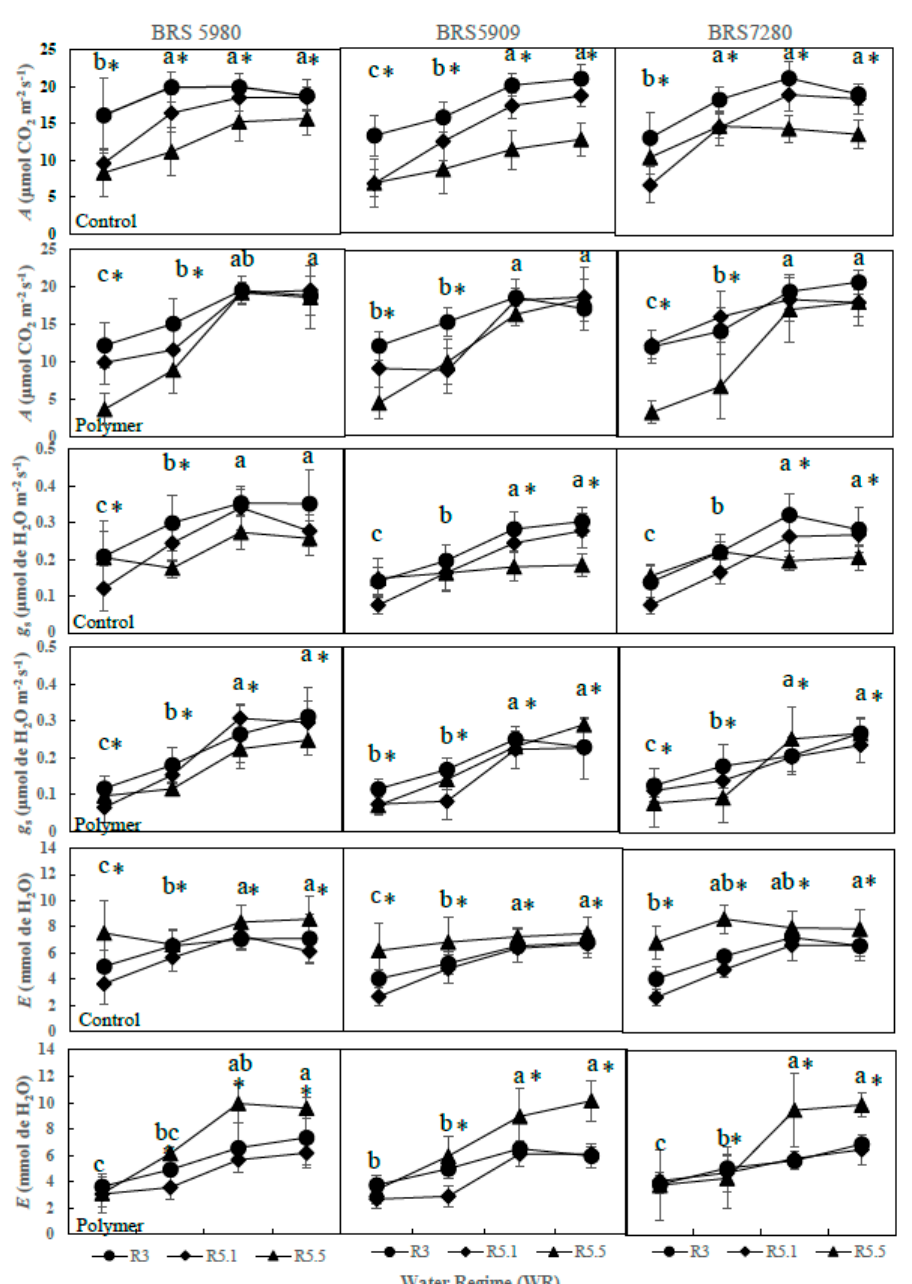
Figure 7. Photosynthesis, ( A ), stomatal conductance ( g s ) and transpiration ( E ) in three soybean cultivars submitted to four water regimes (WR) in three phenological stages of soybean development with and without polymer supply (WR1 167 mm, WR2 237 mm, WR3 341 mm, WR4 534 mm), in 2017. Lowercase letters indicate differences between the WR for each cultivar and * indicates significant differences between the phenological phases within each WR by Tukey’s test ( p < 0.05).